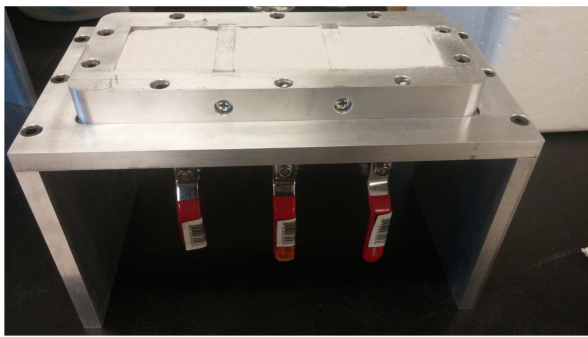
Figure 1. Aluminum mould constructed for cementation